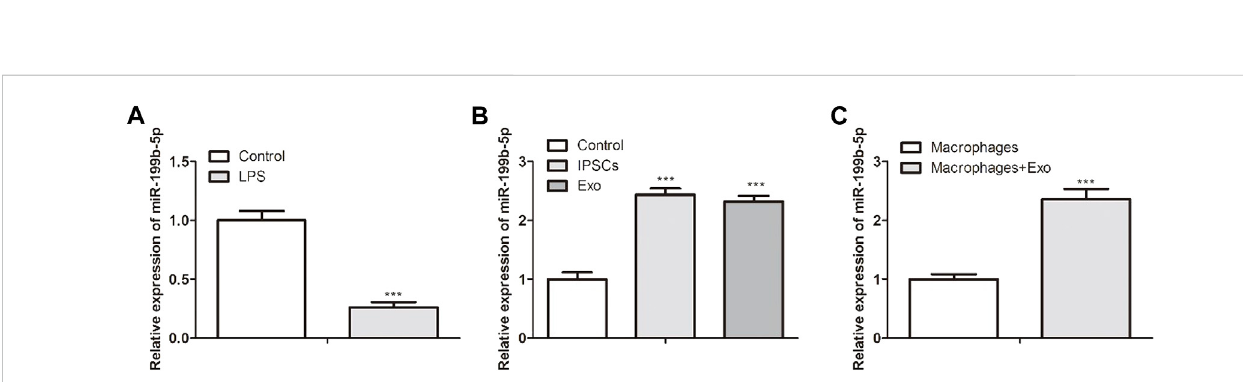
FIGURE 4 IPSCs-ExoregulatedthespinalcordinjuryrecoverythroughmiR-199b-5p. (A) RT-qPCRshowedmiR-199b-5pexpressioninLPS-treatedBMDM. (B) RT- qPCR revealed the miR-199b-5p expression in iPSCs and iPSCs-Exo. *** p < .001 vs. the control group. (C) RT-qPCR revealed the miR-199b-5p expression in LBS-treated BMDM after treatment with iPSCs-Exo. *** p < .001 vs. the macrophages